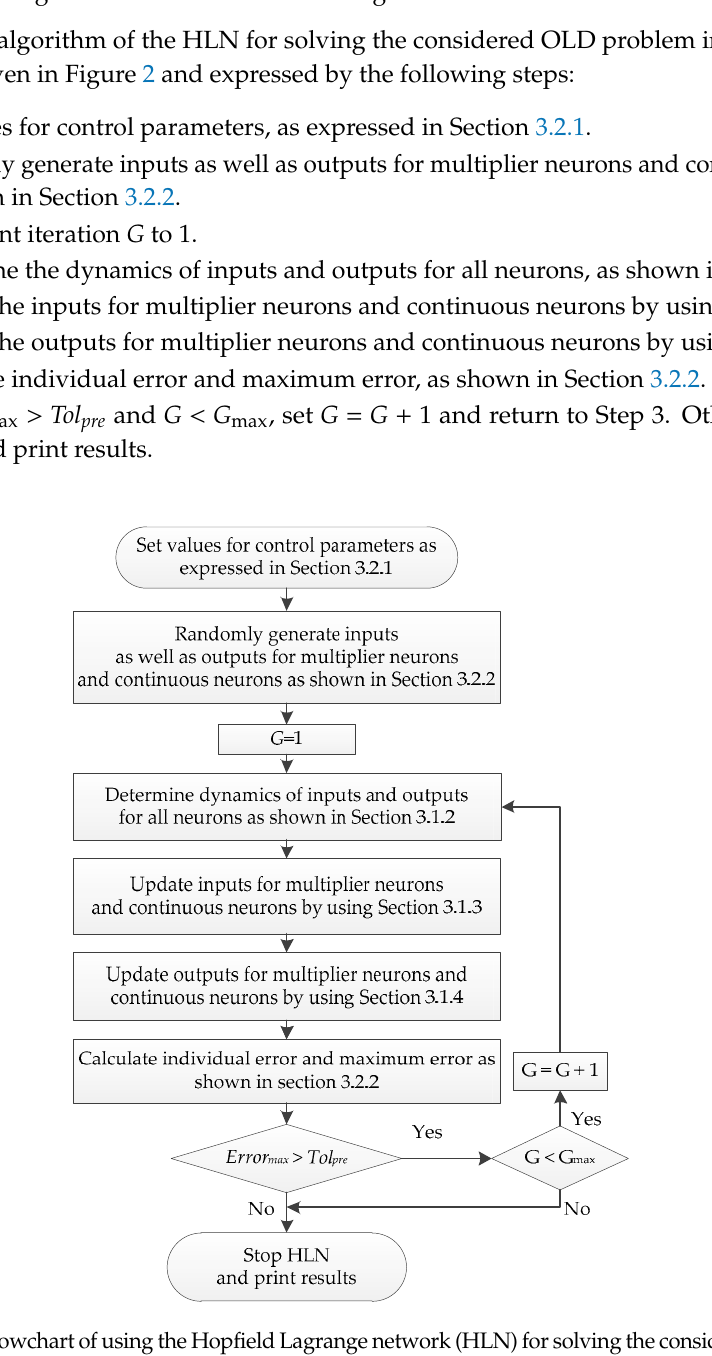
Figure 2. The flowchart of using the Hopfield Lagrange network (HLN) for solving the considered problem.